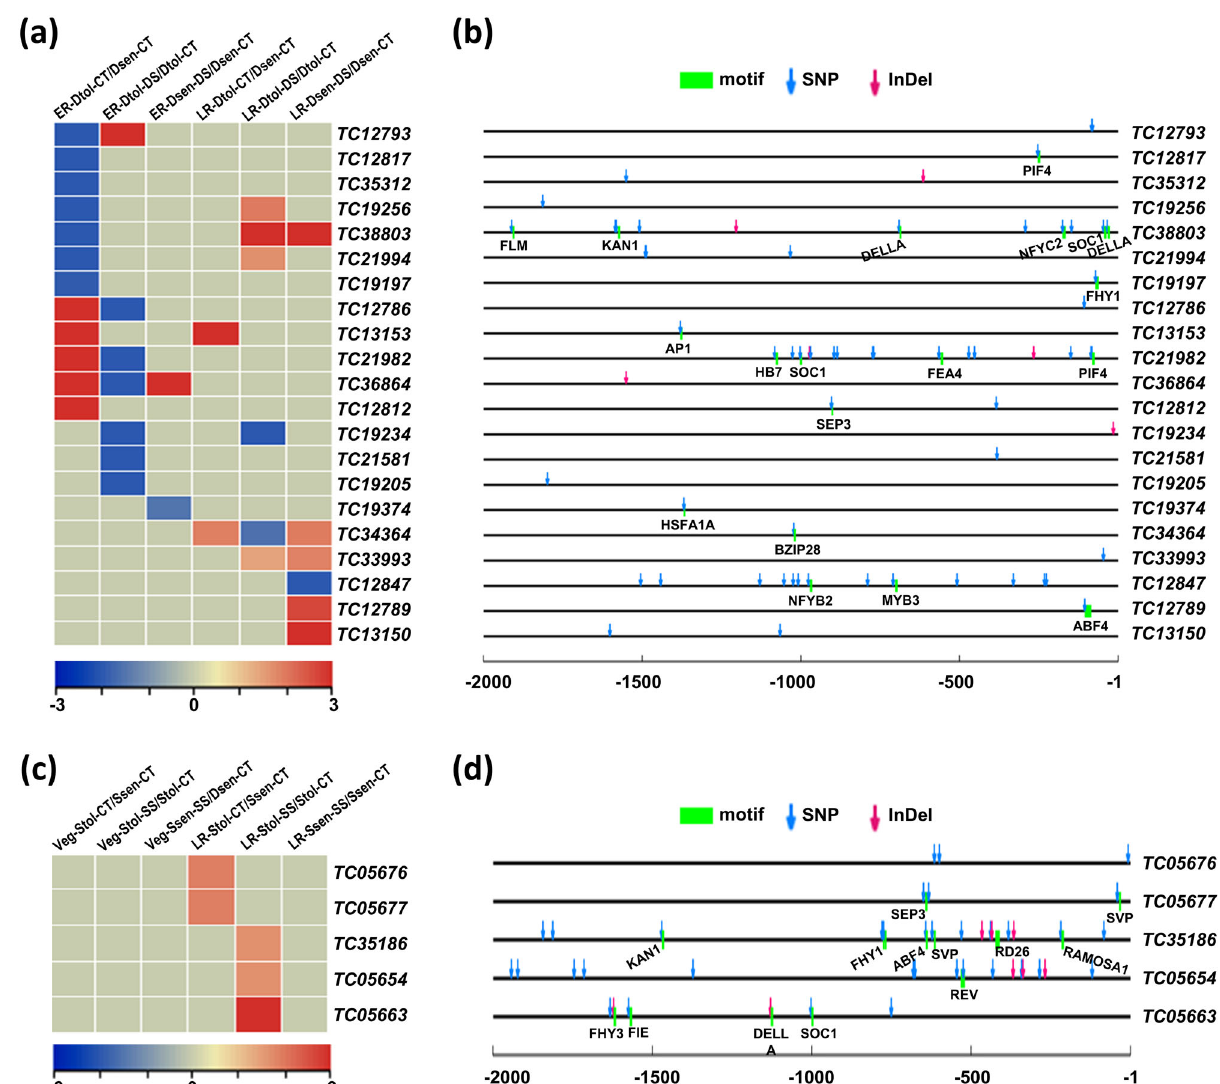
Fig. 8 Candidate transcripts exhibiting abiotic stress-responsive expression associated with quantitative trait loci (QTLs) in the chickpea cultivars. a , c Heatmaps showing the differential expression of transcripts located in the drought ( a ) and salinity ( c ) related QTLs and harbor DNA polymorphisms in their promoter regions. For drought stress ( a ), the differential expression within/between the drought-tolerant (Dtol) and drought-sensitive (Dsen) chickpea genotypes under drought stress (DS) or control (CT) condition at early reproductive (ER) and late reproductive (LR) stages is shown. For salinity stress ( c ), the differential expression within/between the salinity-tolerant (Stol) and salinity-sensitive (Ssen) chickpea genotypes under salinity stress (SS) or control (CT) condition at vegetative (Veg) and late reproductive (LR) stages is shown. Scales at the bottom of a and c represent log 2 fold-change differential expression. b , d The DNA polymorphisms (SNPs and InDels) differentiating the drought-tolerant and drought-sensitive ( b ), and salinity-tolerant and salinity-sensitive ( d ) chickpea genotypes that are located in the promoter (2 kb upstream) regions of the transcripts (given in a and c ) are shown. The cis -regulatory elements harboring the DNA polymorphisms are also